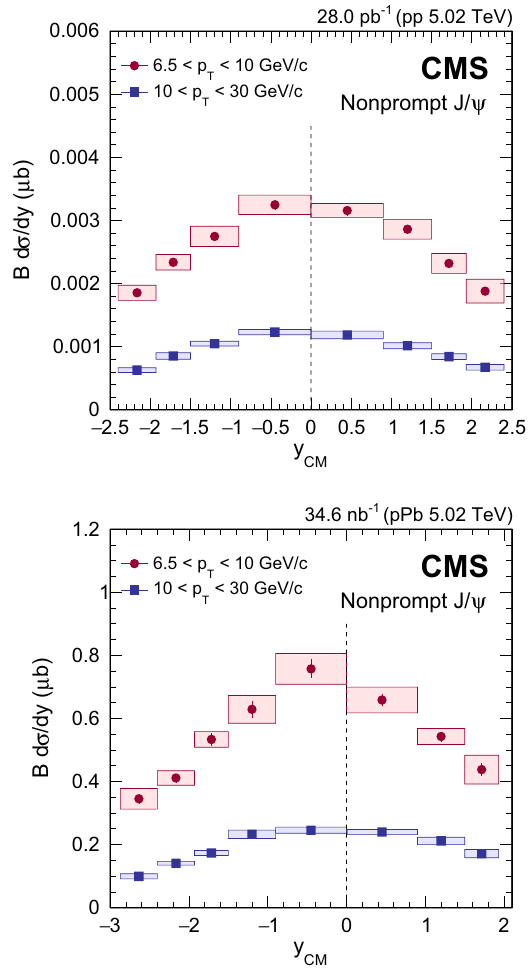
Fig. 9 Rapidity dependence of the cross section (multiplied by the dimuon branching fraction) for nonprompt J /ψ mesons in the p T inter- vals of 6 . 5 < p T < 10GeV / c ( circles ) and 10 < p T < 30GeV / c ( squares ) in pp ( upper ) and pPb ( lower ) collisions. The vertical dashed line indicates y CM = 0. The vertical bars (smaller than the symbols in most cases) represent the statistical uncertainties and the shaded boxes show the systematic uncertainties. The fully correlated global uncer- tainty from the integrated luminosity determination, 2.3% for pp and 3.5% for pPb collisions, is not included in the point-by-point uncertain-